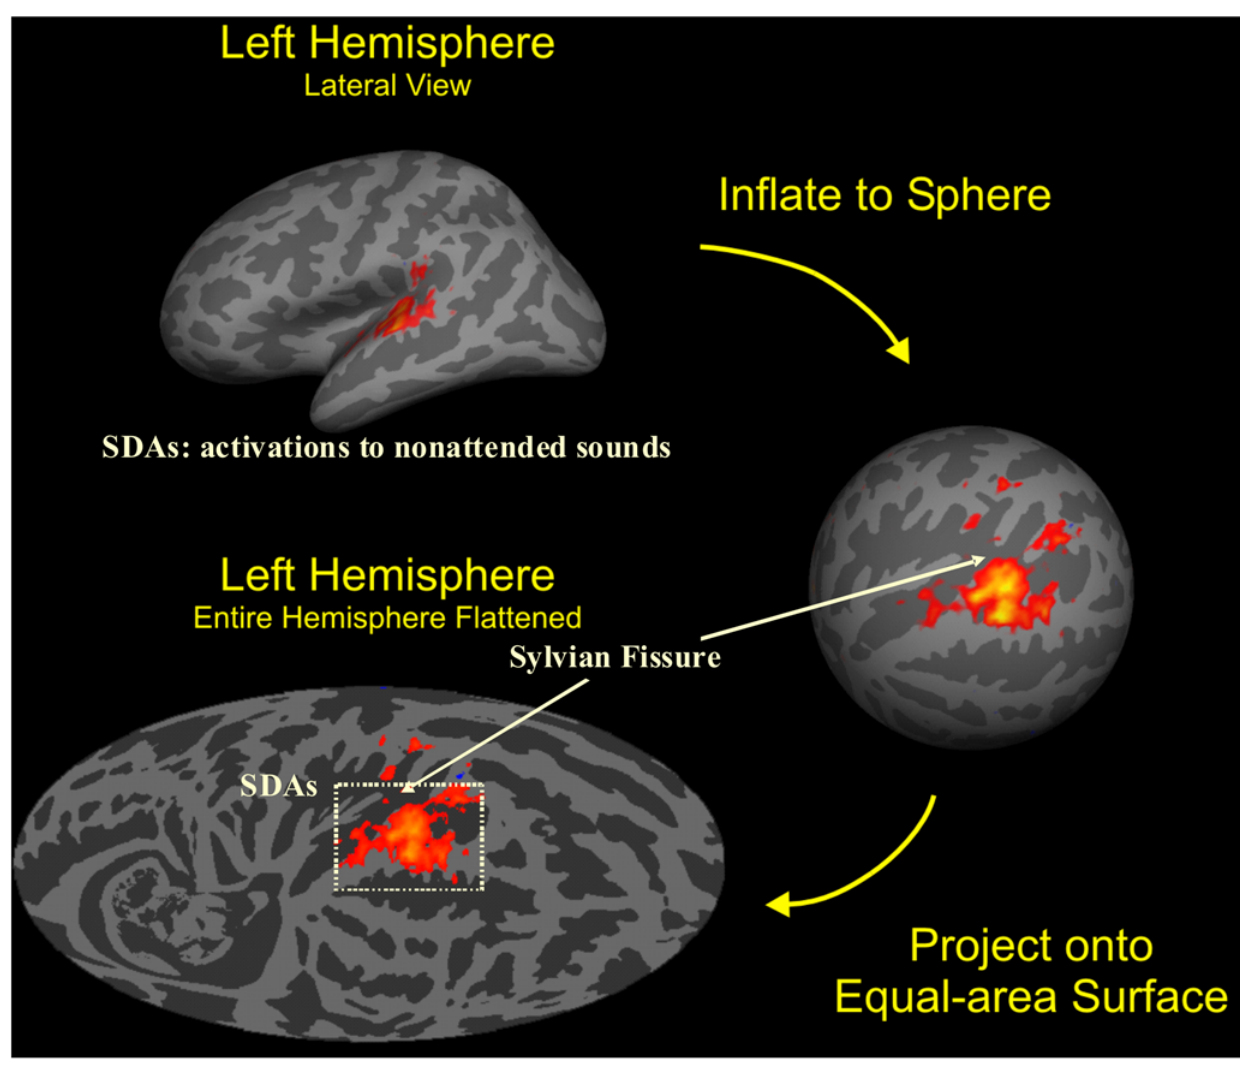
Figure 3. Cortical surface analysis. The cortex from each subject was segmented with FreeSurfer (Fischl, Sereno, Tootell and Dale, 1999) to show gyri (light) and sulci (dark) on the cortical surface, then inflated to a sphere and aligned to a common coordinate system The functional and anatomical data were then mapped onto a Mollweide equal-area projection after rotating the sphere so that the intersection of Heschl’s gyrus (HG) and the superior temporal gyrus (STG) lay at the map center with the STG aligned along the equator. Stimulus-dependent activations (SDAs) averaged over all auditory stimulation conditions and subjects during sparse imaging experiments are shown on the average anatomy of the left hemisphere. Activations were restricted to the regions of auditory cortex near HG with the outlined region enlarged in the figures shown below. Colored voxels show significant activations (t . 3.0) with mean percent signal changes ranging from 0.1–1.0% (red to yellow).